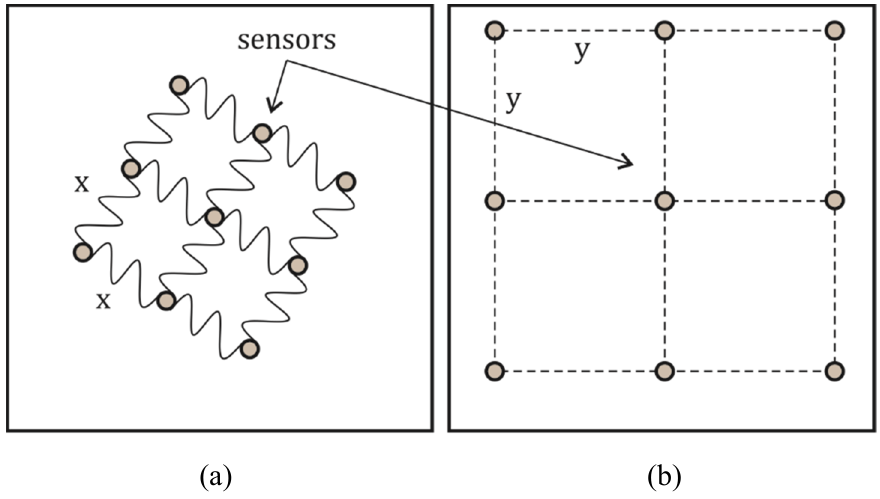
Figure 5. The concept of the stretchable sensor network where the distances between sensors before deployment ( a ) are short in comparison to the deployed network ( b ): x << y.